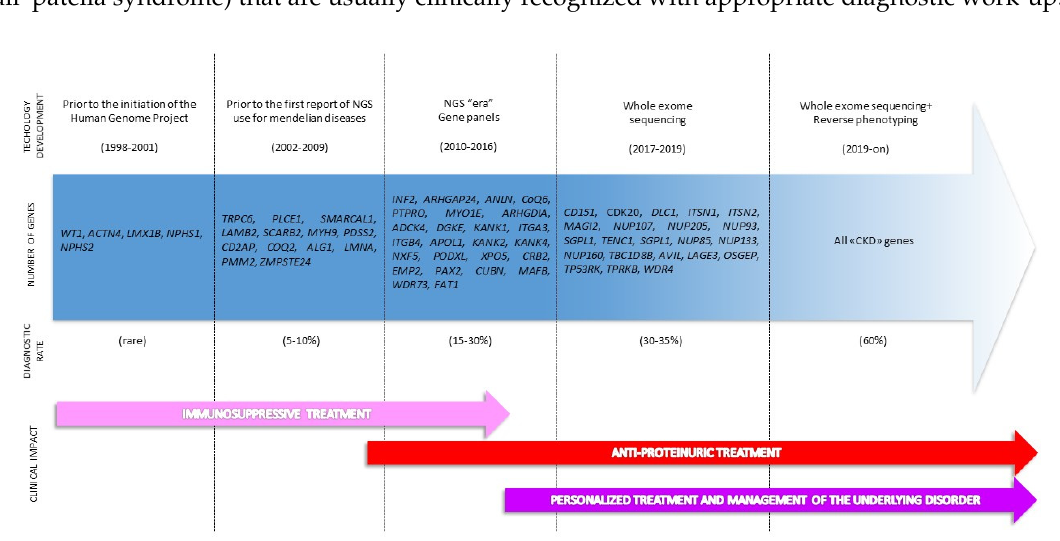
Figure 1. Evolution of genetic diagnosis in steroid-resistant nephrotic syndrome (SRNS). This picture illustrates the advances in the genetic diagnosis of SRNS encompassing technological improvement and analytic strategies. The main cornerstones of sequencing technology development, the genes reported as causative of SRNS and the diagnostic rates are reported. NGS, next-generation sequencing; CKD, chronic kidney disease.